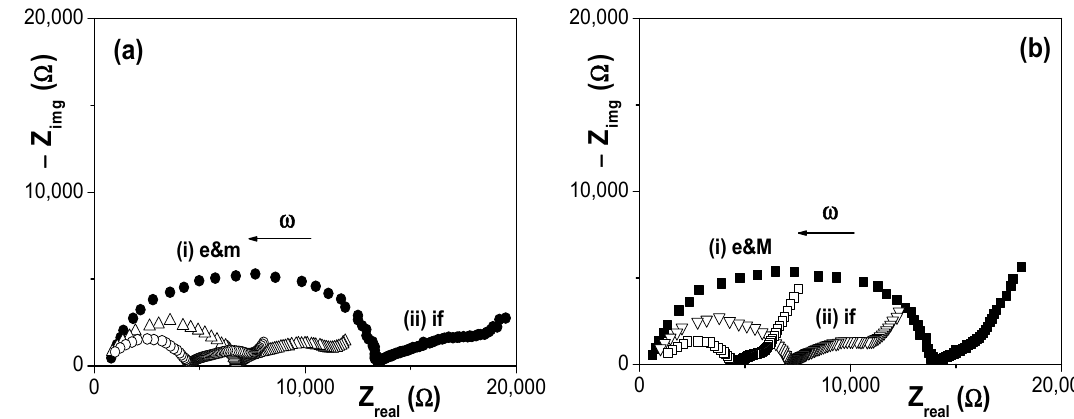
Figure 7. Comparison of Nyquist plots obtained for three different NaCl solution concentrations. ( a ) Ox–SiO 2 /APTES membrane system: ( ● ) 0.002 M NaCl solution, ( Δ ) 0.006 M NaCl solution and (o) 0.01 M NaCl solution. ( b ) Ox– SiO 2 /APTES/O 3 membrane system: ( ■ ) 0.002 M NaCl solution, ( ▽ ) 0.006 M NaCl solution and ( □ ) 0.01 M NaCl solution.